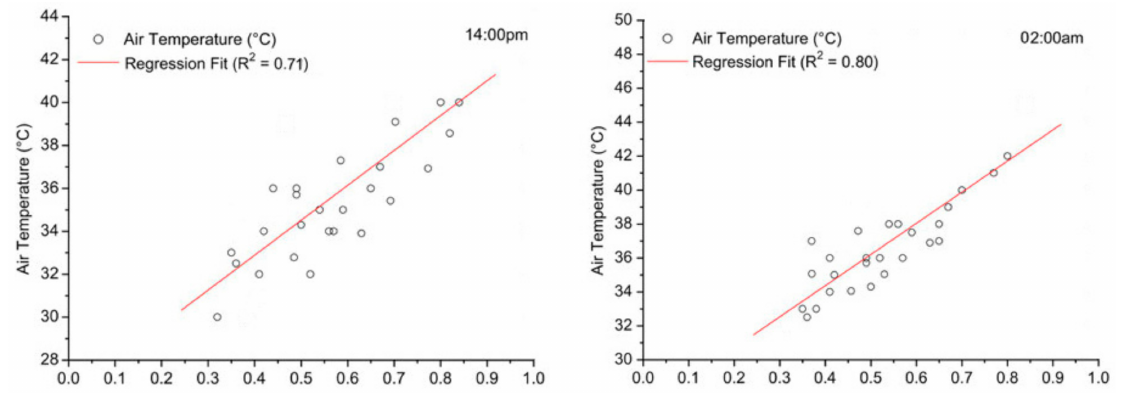
Figure 11. Comparison of model results with weather station data.